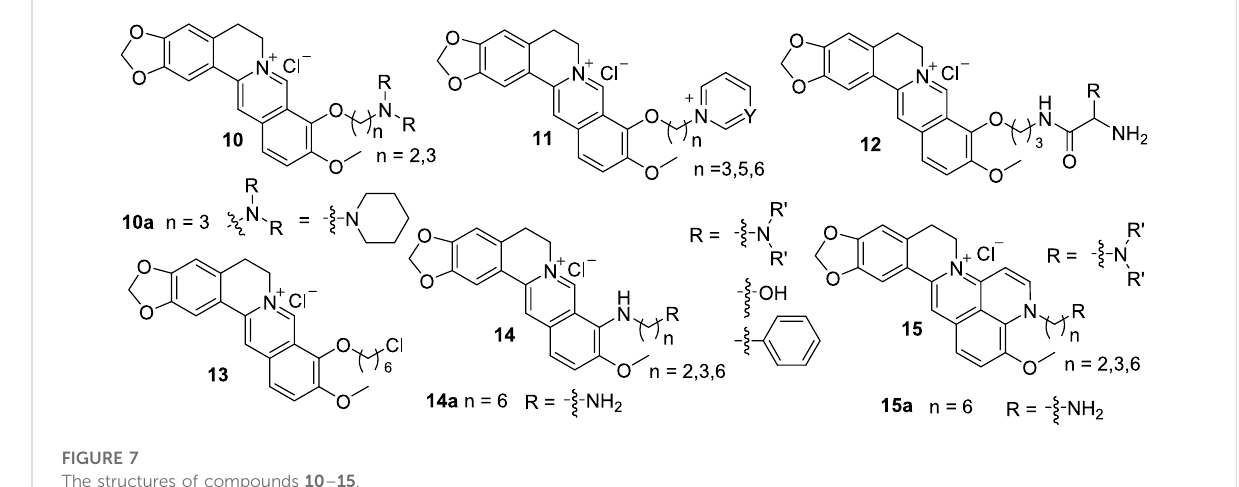
FIGURE 7 The structures of compounds 10 – 15